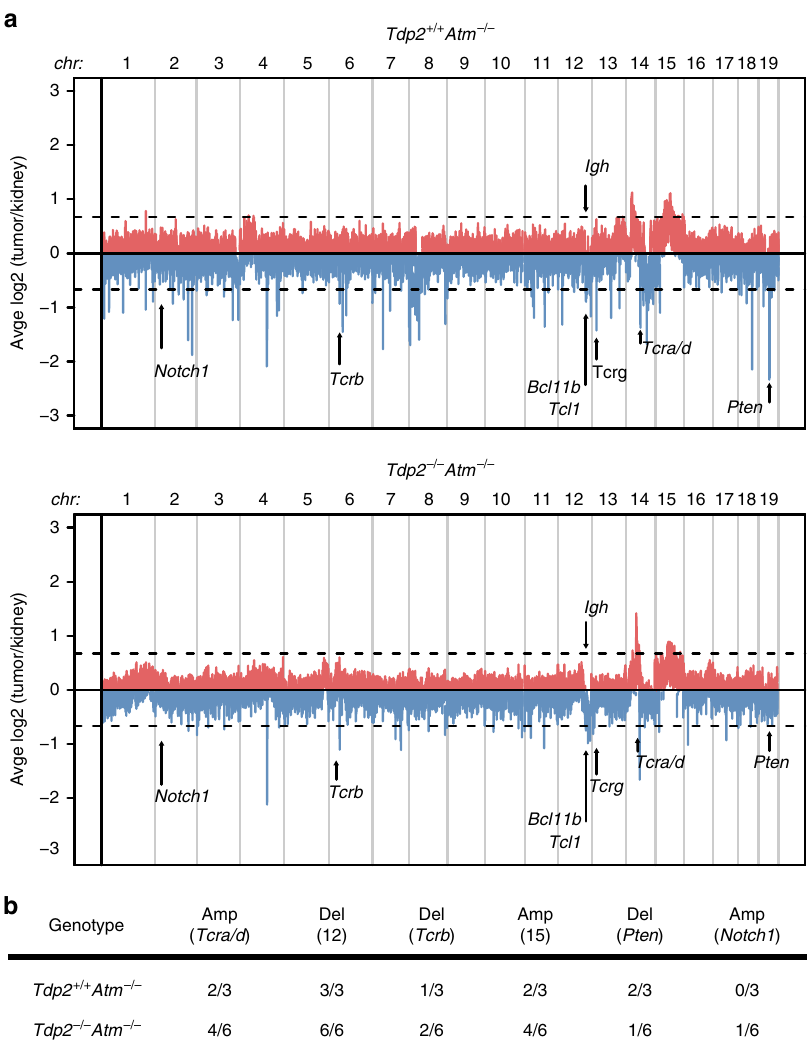
Fig. 3 Tdp2 − / − Atm − / − and Atm − / − thymic malignancies display similar genome rearrangements. a Merged CGH analysis of Tdp2 + / + Atm − / − (three mice, top) and Tdp2 − / − Atm − / − (six mice, bottom) thymic lymphomas. DNA from each tumour sample was hybridized and analysed using kidney DNA from the same mouse as a control. Average ampli fi cation (red) or deletion (blue) score (Log2 tumour/kidney ratio) is shown. Signi fi cant copy number variations are de fi ned by − 0.66>Log2 tumour/kidney>0.66 (dashed lines). The location of relevant loci in Atm − / − thymic tumours is indicated. b Table summarising the number of mice of each genotype displaying copy number variation at the indicated locus of interest. Amp( Tcra/d ): ampli fi cation upstream of Tcra/d ; Del(12): deletion of the telomeric region of chromosome 12 covering Bcl11b ; Del( Tcrb ): deletion at the Tcrb locus; Amp(15): trisomy of chromosome 15; Del( Pten ): deletion at the Pten locus; Amp( Notch1 ): duplication at the Notch1